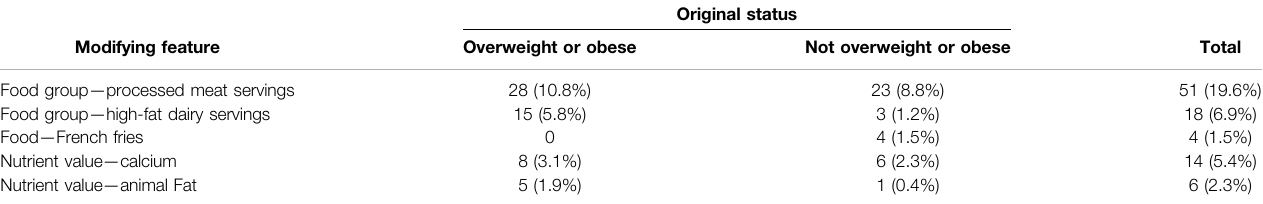
TABLE 4 | Predicted responses in overweight and obesity status of subjects with simulated dietary feature changes in the test data set of the FOS ( n (cid:1)